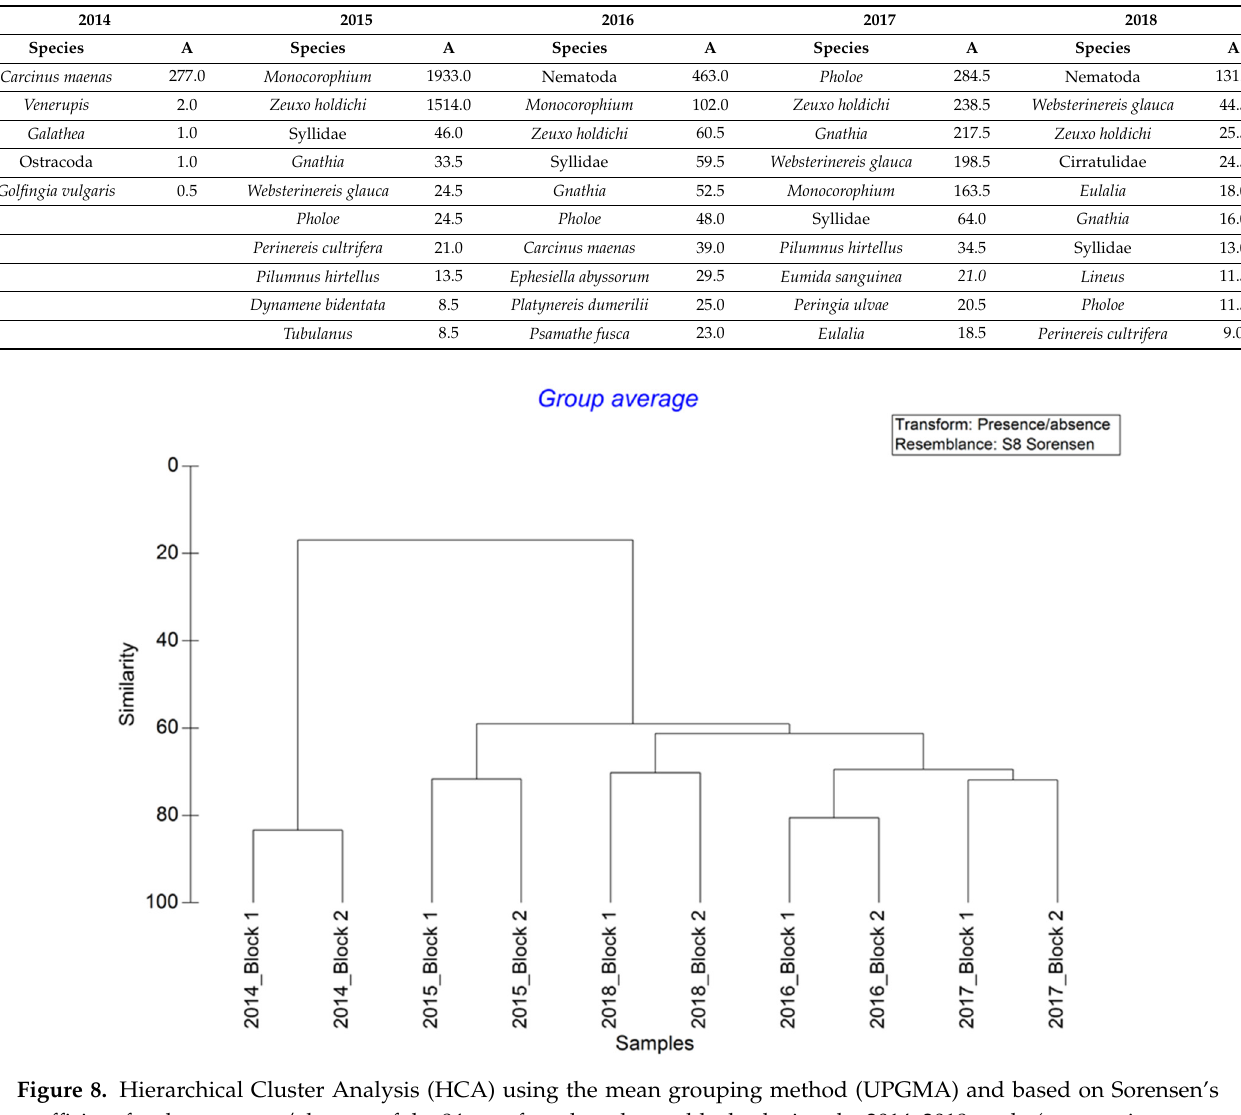
Table 5. Mean abundance (A per 0.6 m 2 ) of the ten dominant motile taxa found on the blocks sampled from 2014 to 2018 (one, two, three and four years after the beginning of the study).